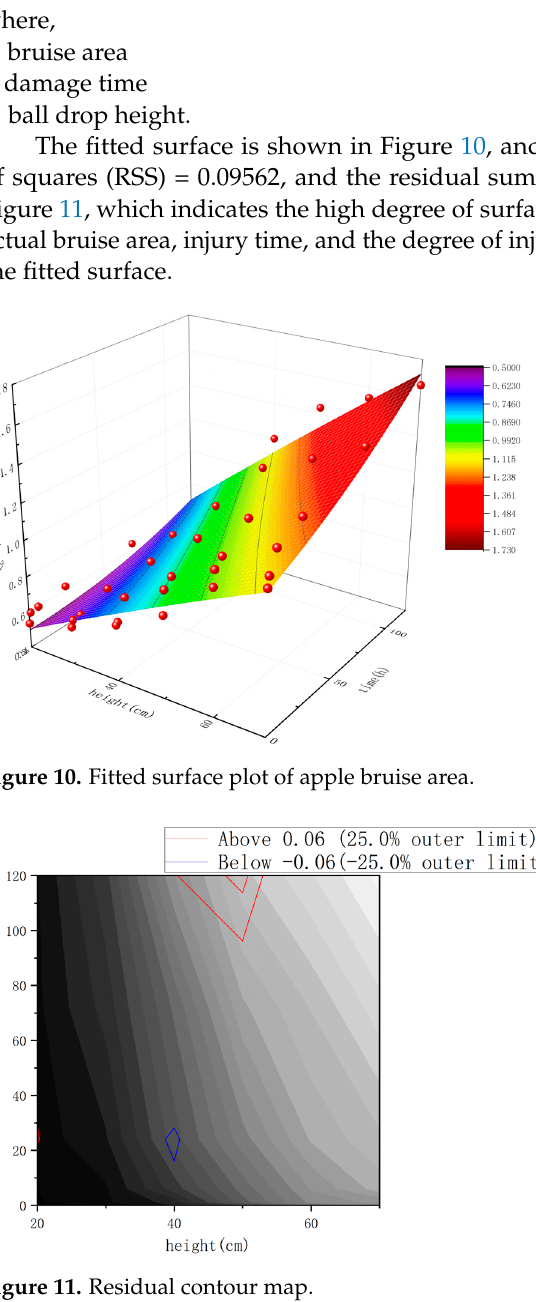
Figure 11. Residual contour map.